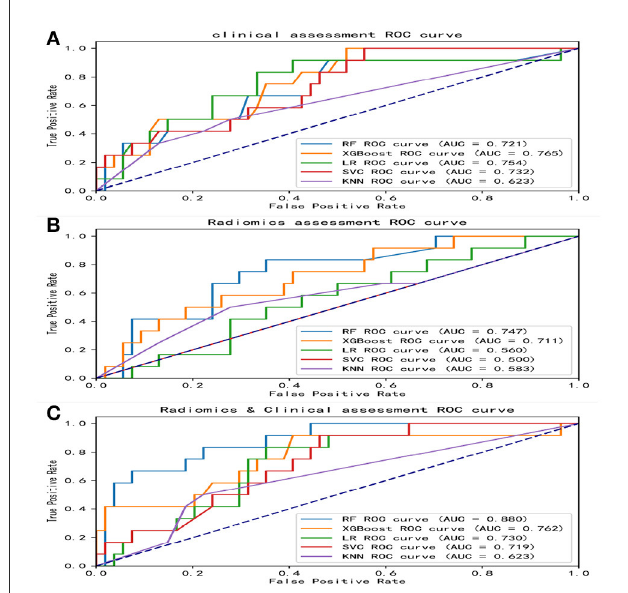
FIGURE5 ROC curves of various models. The area under the ROC curves (AUCs) of five different machine learning models constructed from radiomics features, clinical features, and combined features, respectively. (A) ROC curves of five machine learning models built with clinical features. (B) ROC curves of five machine learning models built with radiomics features. (C) ROC curves of five machine learning models built with combined features. ROC, receiver operating characteristic; AUC, area under curve; RF, random forest; XGBoost, eXtreme gradient boosting; LR, logistic regression; SVM, support vector machines; KNN, k-nearest